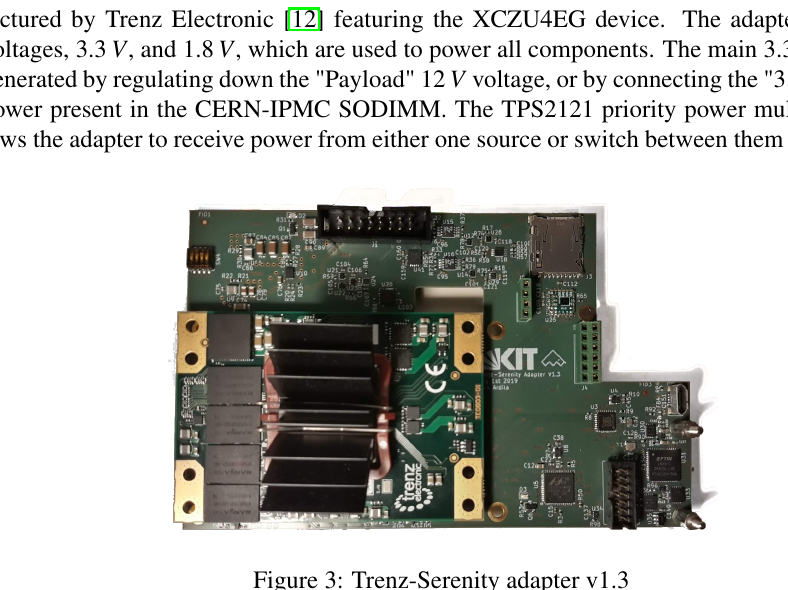
Figure 3: Trenz-Serenity adapter